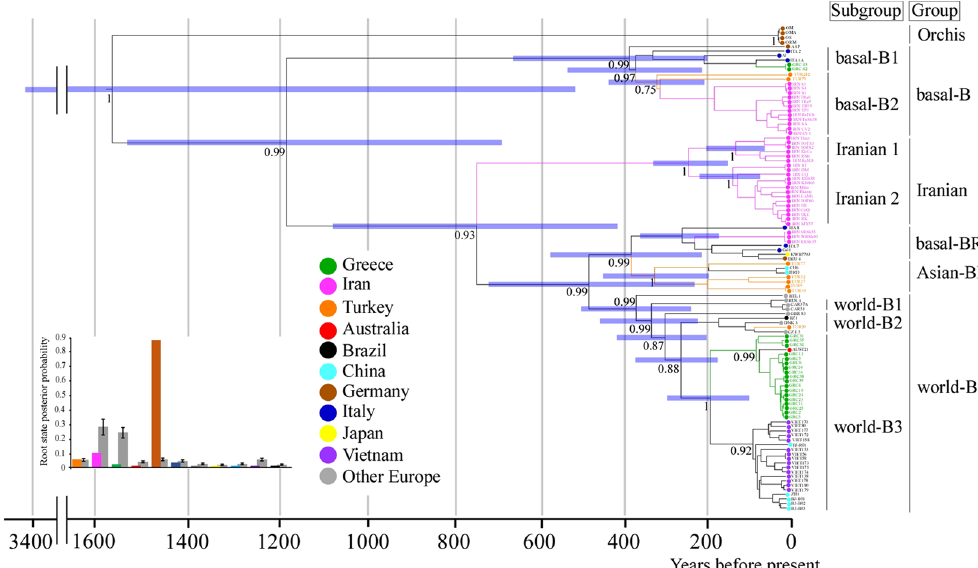
Figure 4. Bayesian maximum-clade-credibility chronogram inferred from the polyprotein-coding region of turnip mosaic virus genomes. The tree was estimated from the major open reading frame (ORF) sequences of 106 non-recombinant isolates. Detail of the region is given in the Methods. Horizontal blue bars represent the 95% credibility intervals of estimates of node ages. The bar graph shows the root state posterior probabilities for each location. Grey bars show the probabilities obtained with 10 randomizations of the tip locations. Year before present;